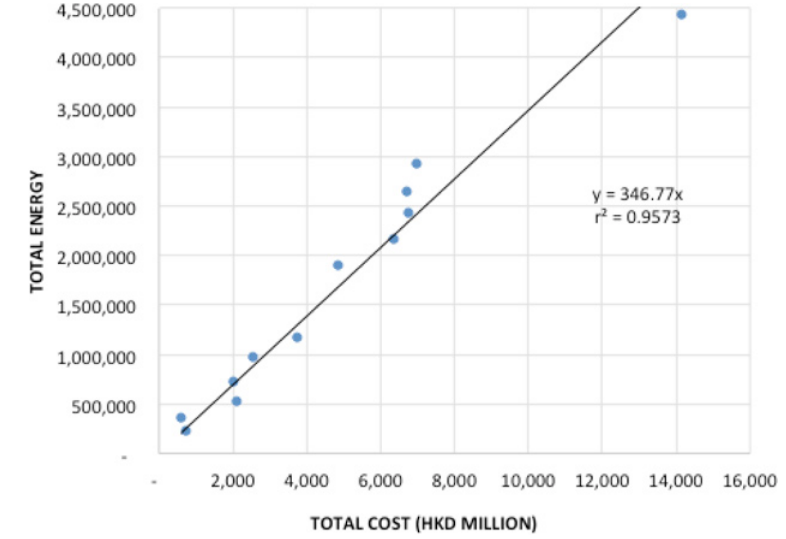
Figure 2 New-build EE versus Cost (Hong Kong)